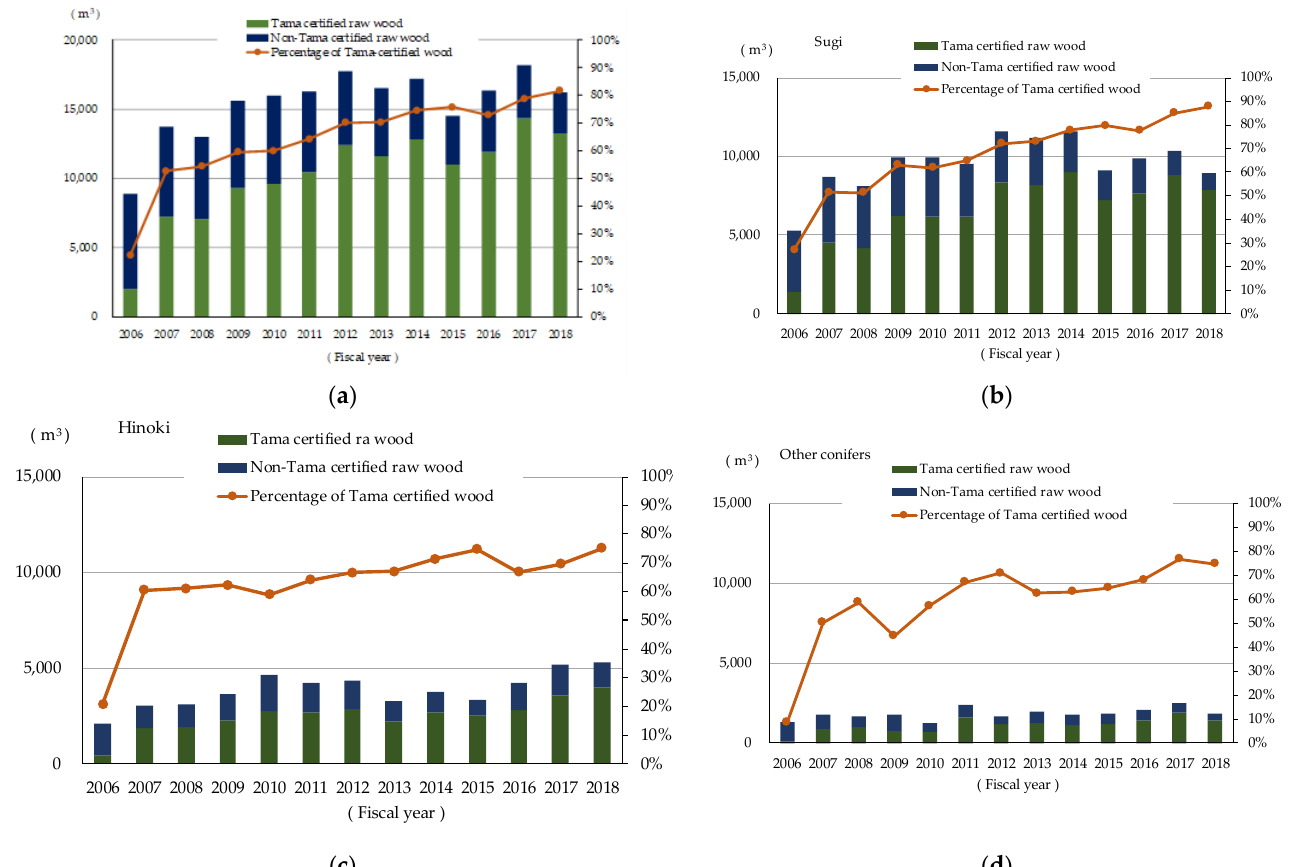
Figure 6. Handling volume of Tama-certified raw wood at Tama Roundwood Market Center: ( a ) handling volume of the entire center; ( b ) handling volume of sugi; ( c ) handling volume of hinoki; ( d ) handling volume of other conifers.